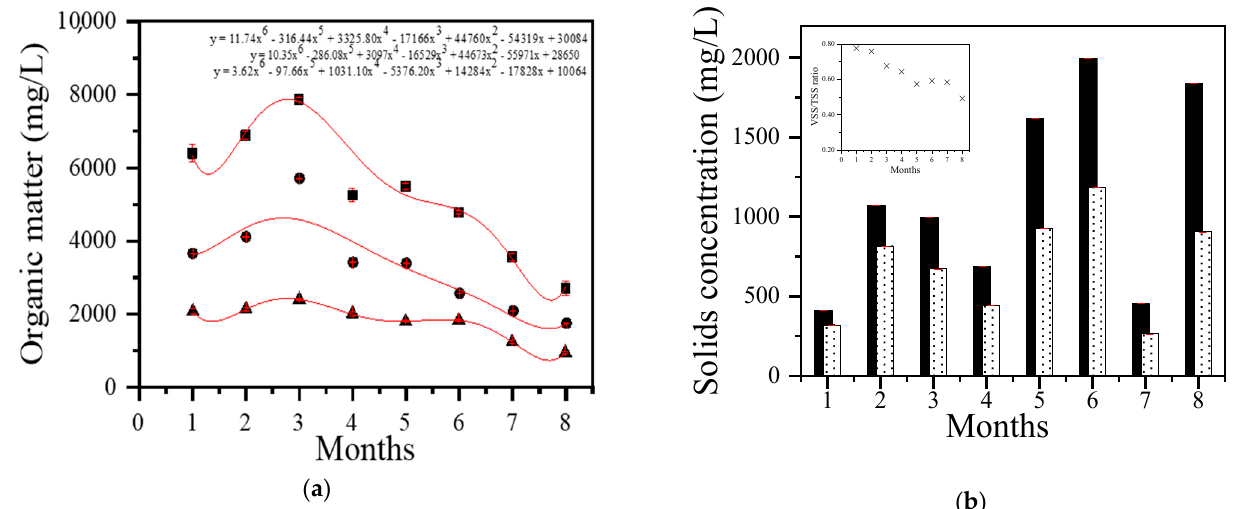
Figure 2. Characterization of winery wastewater during eight months of monitoring, ( a ) content of organic matter ( ■ ) sCOD, ( ● ) BOD 5 , ( ▲ ) TOC, polynomial fit; ( b ) concentration of solids ( █ ) TSS, ( ░ ) VSS, (X) VSS/TSS ratio. Specification: the values of the parameters correspond to the average ) value of the parameter according to the samples collected in each month. Table 2 shows the behavior of other wastewater parameters measured over time. The samples presented color differences, which is related to the type of wine produced and